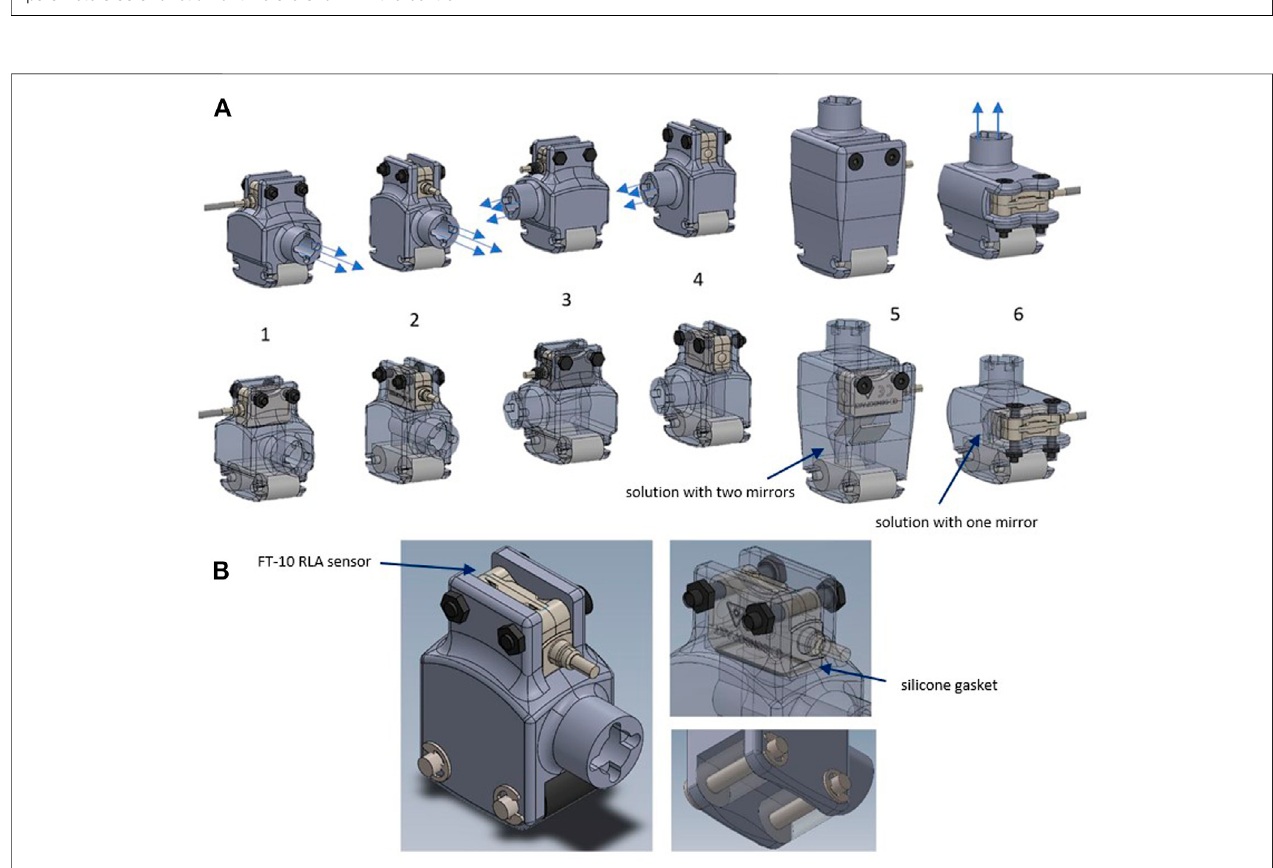
FIGURE 3 | (A) Different design solution for prototypal device; (B) selected solution of prototype probe for LPG massage.